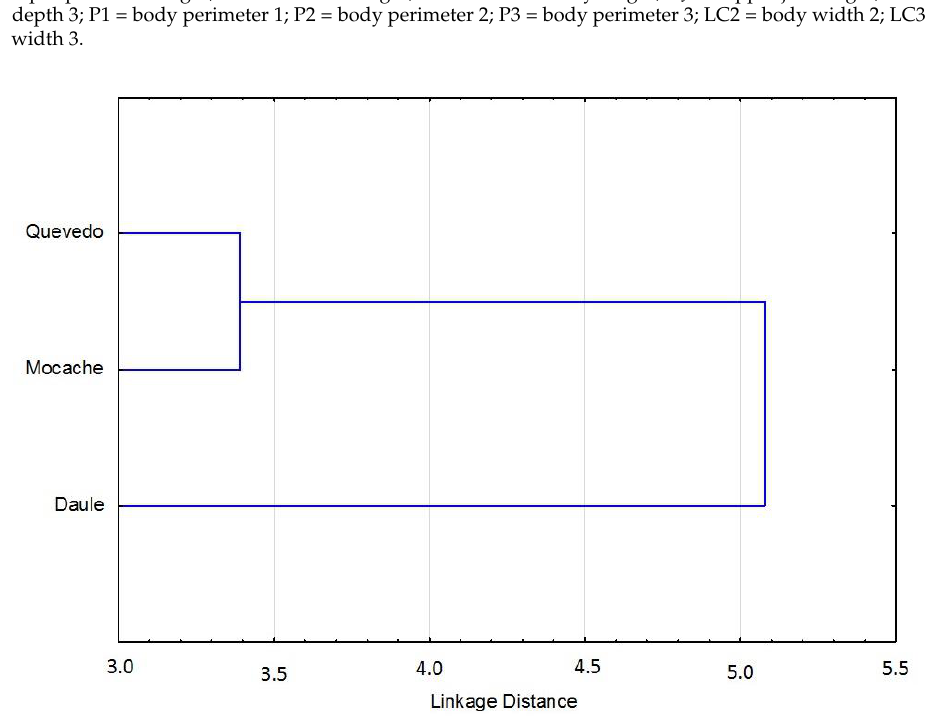
Figure 3. Clusters of Mahalanobis distances of Brycon dentex from three rivers.